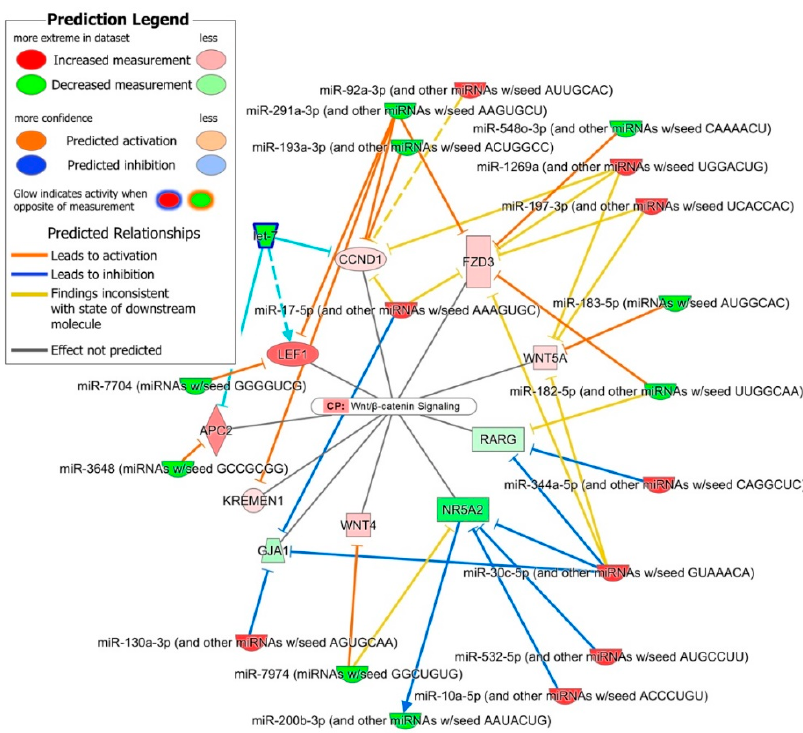
/ β -catenin canonical